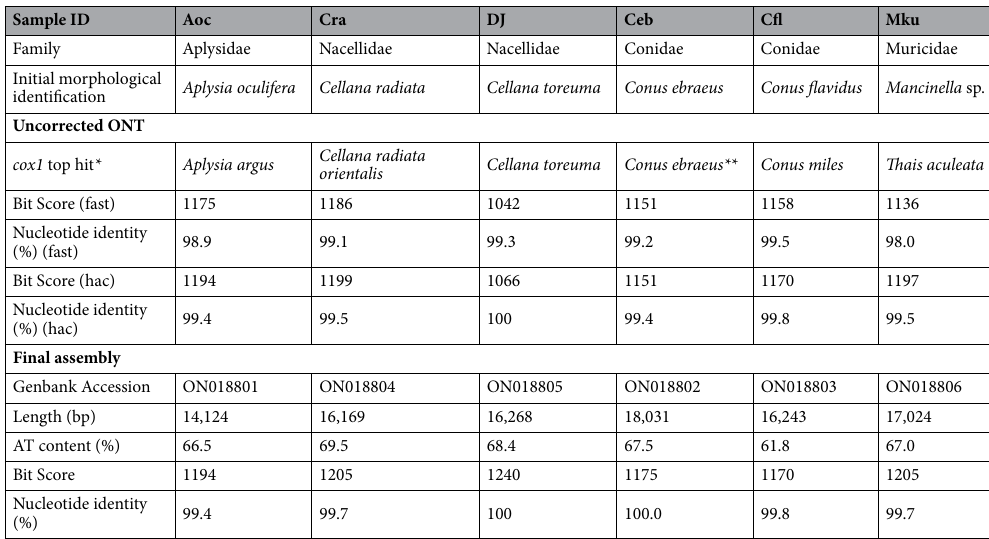
Table 1. Sample identification (ID) codes, together with original morphological identification and BLASTn results of the cox1 sequence. *Latest species names are provided in the table; some were not yet updated in GenBank. ** Conus cloveri with 87.2% nucleotide identity was identified as top hit when the full cox1 sequence was used. We searched instead using Folmer region and identified C. ebraeus with much higher nucleotide